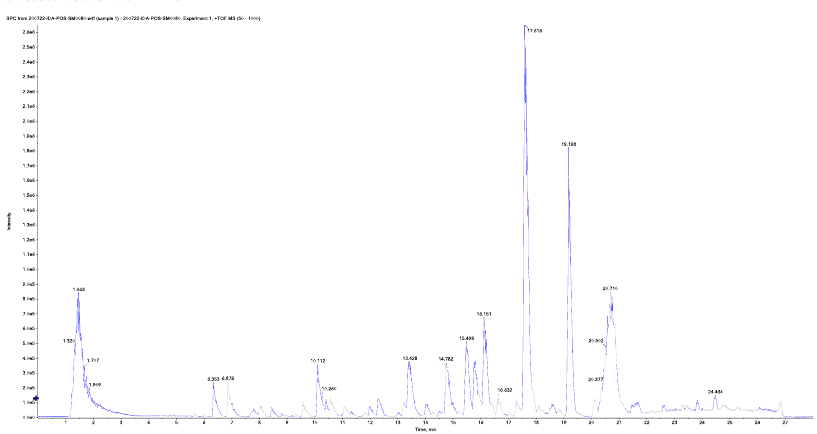
Figure 6. Chromatogram of methanolic extract of M. alysson L. in positive ion